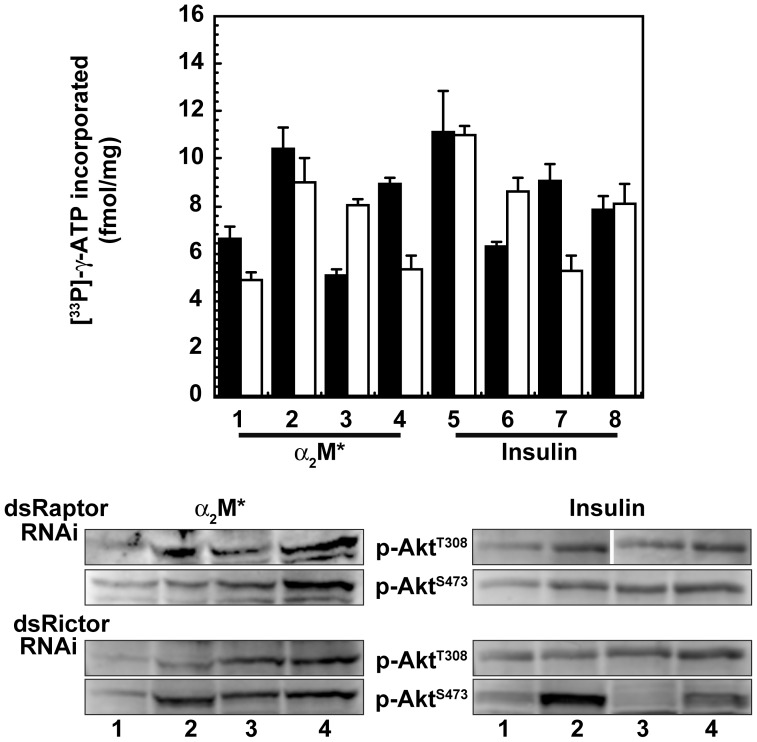
Akt phosphorylation of T308 and S473 are independent events. Panel A.A bar diagram showing independence of phosphorylation of Akt at T308 (▪) and S473 (□) in kinase assays of the 1-LN cancer cells stimulated with α2M* (50 pM/25 min) or insulin (200 nM/20 min). The bars are: (1) lipofectamine + buffer; (2) lipofectamine + α2M* (50 pM/25 min); (3) Raptor dsRNA (100 nM/48 h) then α2M*; (4) Rictor dsRNA (100 nM/48 h) then α2M*; (5) lipofectamine + insulin; (6) Raptor dsRNA (100 nM/48 h), then insulin (200 nM/20 min); (7) Rictor dsRNA (100 nM/48 h) + insulin; and (8) scrambled dsRNA (100 nM/48 h) then insulin. Values are mean ± SE from three experiments and are expressed as fmol [33P]-γ-ATP incorporated/mg cell protein. Panel B. Levels of p-AktT308 and p-AktS743 in cell lysates of 1-LN cells treated with α2M* (50 pM/25 min) or insulin (200 nM/15 min). Representative immunoblots of p-AktT308 and p-AktS473 from three experiments of cells transfected with Raptor dsRNA or Rictor dsRNA as above are being shown.